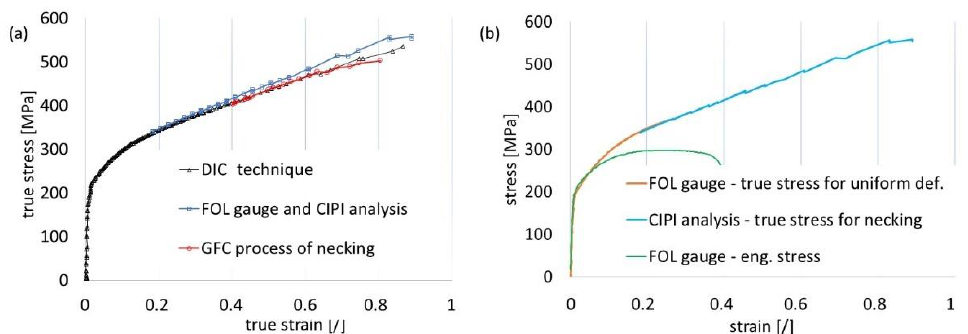
Figure 16. Correction of the true stress – strain curve calculation: ( a ) distribution of the necking length parameter characteristic for the last 20 frames of recorded tension test, ( b ) distribution of the correction factor. Figure 17. Comparisons of results for the true stress – strain curve: ( a ) DIC and image processing, ( b ) Figure 17. Comparisons of results for the true stress–strain curve: ( a ) DIC and image processing, image processing using fibre-lighting and contour calculation. ( b ) image processing using fibre-lighting and contour